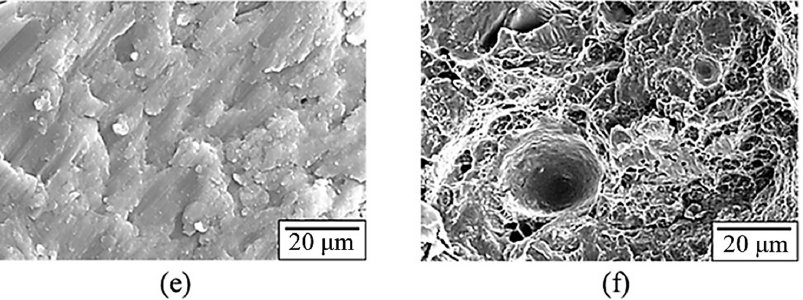
Figure 10. Microstructure of fatigue fracture of the SLM Al–Mg–Sc–Zr alloys under 7 kg load propagation region: ( a ) as-printed and ( c ) single-stage- and ( e ) two-stage-heat-treated specimens; final fracture region: ( b ) as-printed and ( d ) single-stage- and ( f ) two-stage-heat-treated specimens. Table 6. Fatigue resistance of SLM Al–Mg–Sc–Zr alloys. Load (kg) Stress (kg/mm 2 )